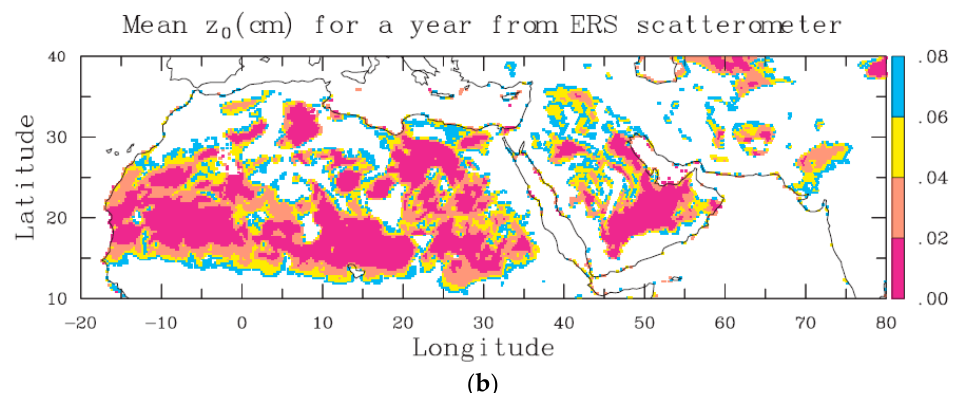
Figure 9. Maps of aerodynamic roughness classes over the Sahara desert: ( a ) derived from a CYGNSS reflectivity database, ( b ) derived from the European Remote-Sensing Satellite (ERS) scatterometer (Prigent et al. [4]).